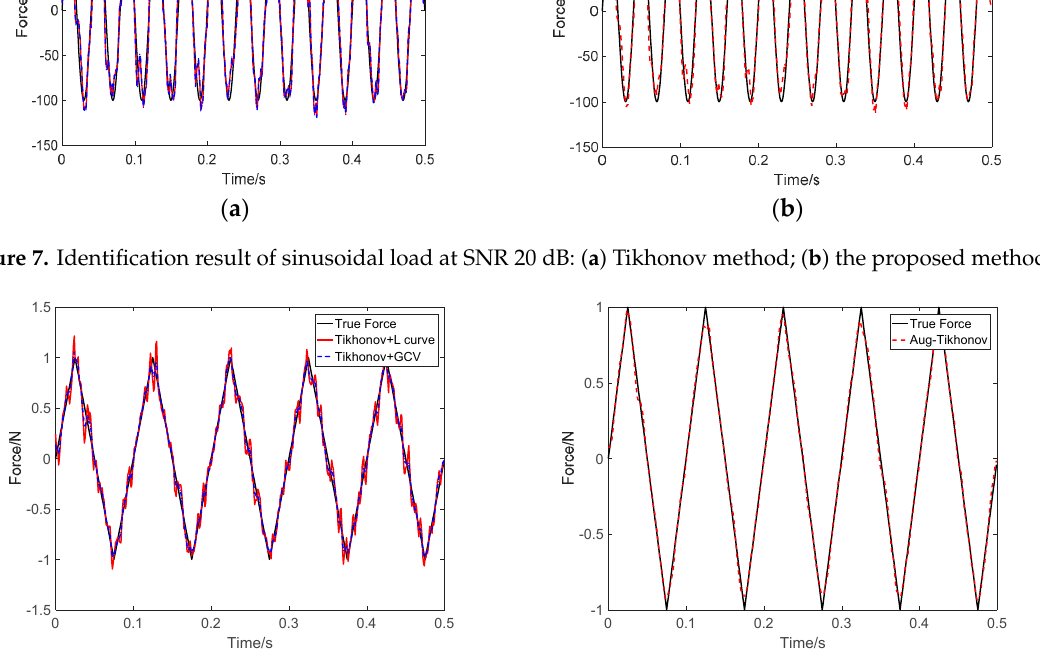
Figure 8. Identification result of triangle wave load at SNR 40 dB: ( a ) Tikhonov method; ( b ) the proposed method.